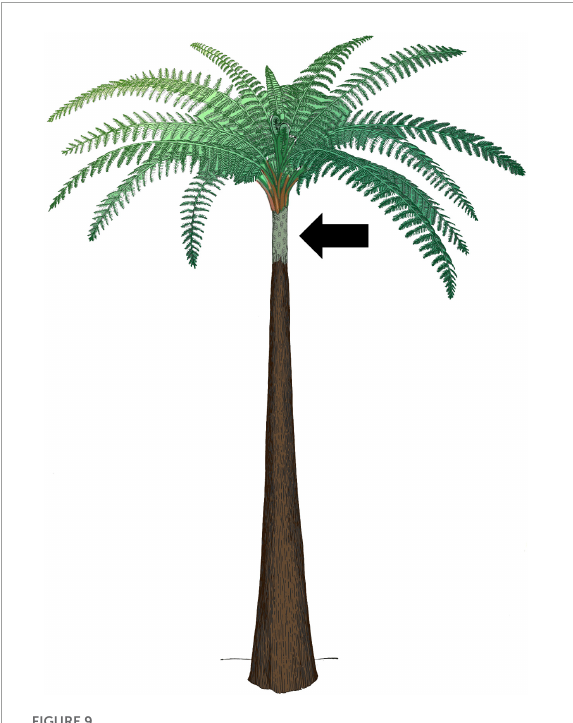
FIGURE9 Reconstruction of Psaronius adapted from Morgan (1930), colorized by the authors based on pictures of nearest living relative, Angiopteris sp., to help distinguish between plant organs. Black arrow indicates the only visible segment of the stem (colored in green-gray). All structures above the visible stem segment (red-green and green) are petioles and megaphylls. The extensive brown structure below the visible stem represents the extensive mantle of adventitious roots that extended below the stem and formed the majority of the apparent